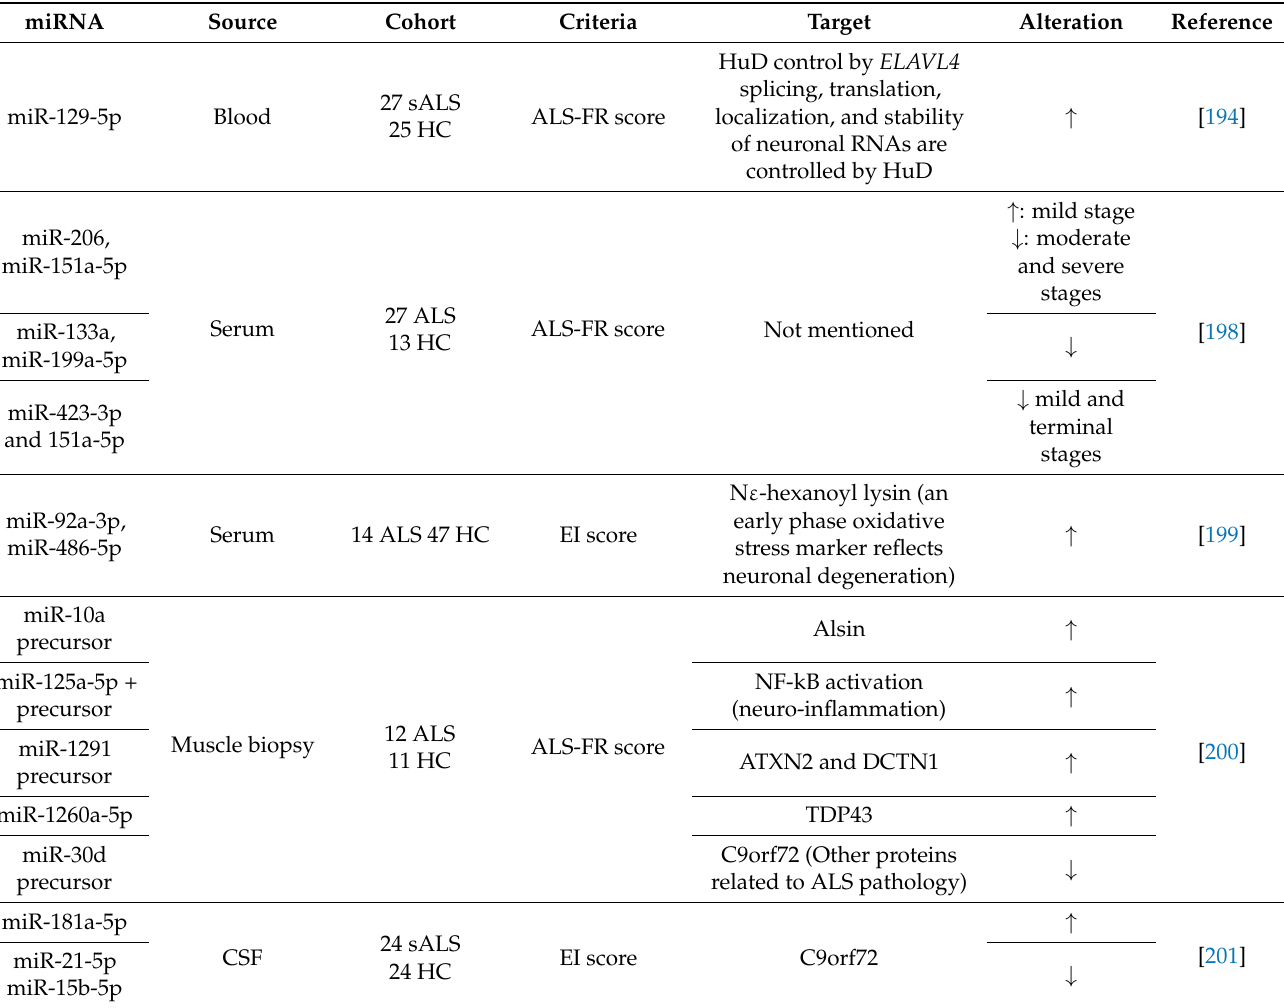
Table 6. Profile of miRNAs proposed as amyotrophic lateral sclerosis disease